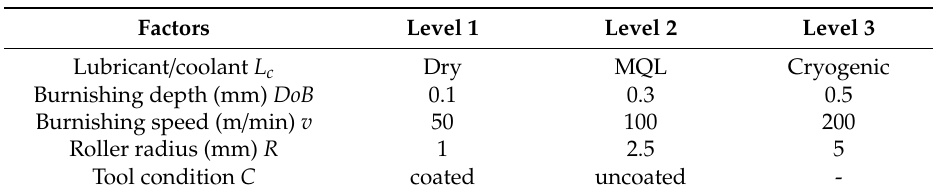
Table 1. Design of experiments for burnishing Ti-6Al-4V alloy.